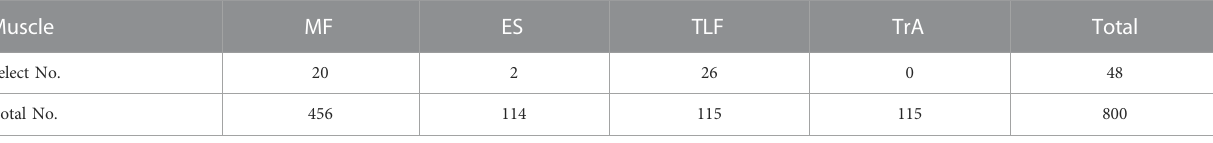
TABLE 7 The number of features from different muscles in the optimal feature set. Muscle MF ES TLF TrA Total Select No. 20 Total